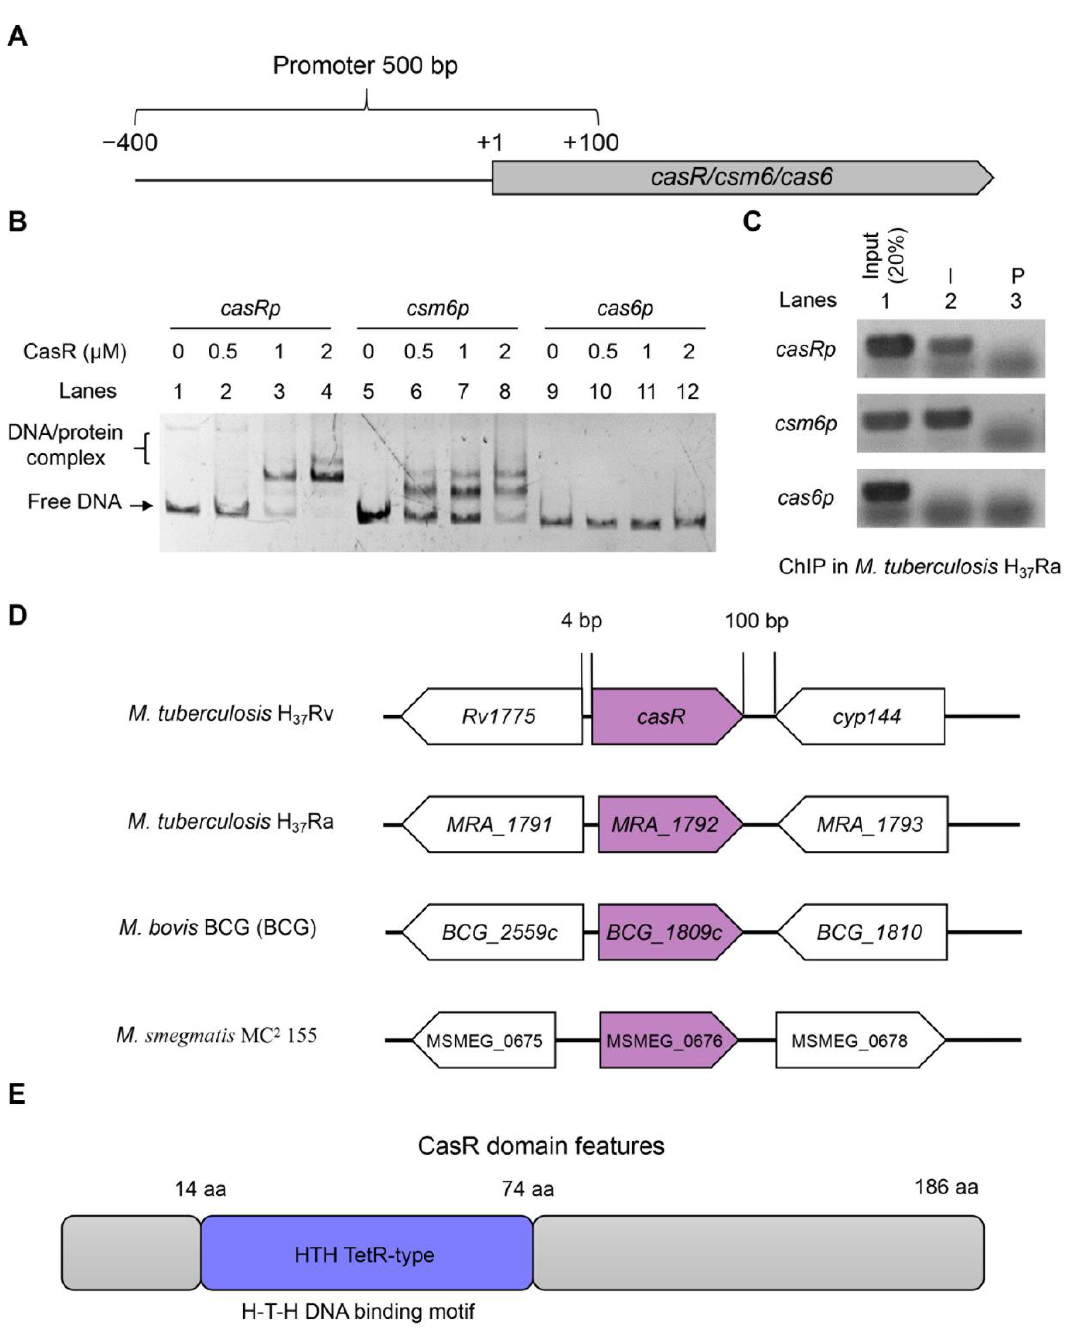
Figure 3. Specific interaction of CasR with the promoter of the csm6 in CRISPR-Cas system of M. tuberculosis . ( A ) Schematic diagram of the promoter fragment used in this experiment. ( B ) EMSA of CasR binding to its own promoter and CRISPR system promoters. The 100 ng casR promoter ( casRp , Lanes 1 – 4) and 100 ng target gene csm6 promoter ( csm6p , Lanes 5 – 8) were incubated with different concentrations (0 –2 μM) of CasR protein. The non-specific promoter cas6p (Lanes 9 – 12) served as a negative control. The DNA – protein complex is indicated with square brackets. ( C ) ChIP assay in the wild-type M. tuberculosis H 37 Ra strain. In ChIP, P indicates pre-immune serum, and I denotes antiserum against CasR. The mycobacterial promoter cas6p was used as a negative control. ( D ) CasR amino acid sequence with 100% identity in M. tuberculosis H 37 Rv, M. tuberculosis H 37 Ra, and M. bovis BCG. ( E ) Domain characteristics of CasR. CasR contained an HTH TetR_type superfamily domain and a C-terminal domain with unknown function.